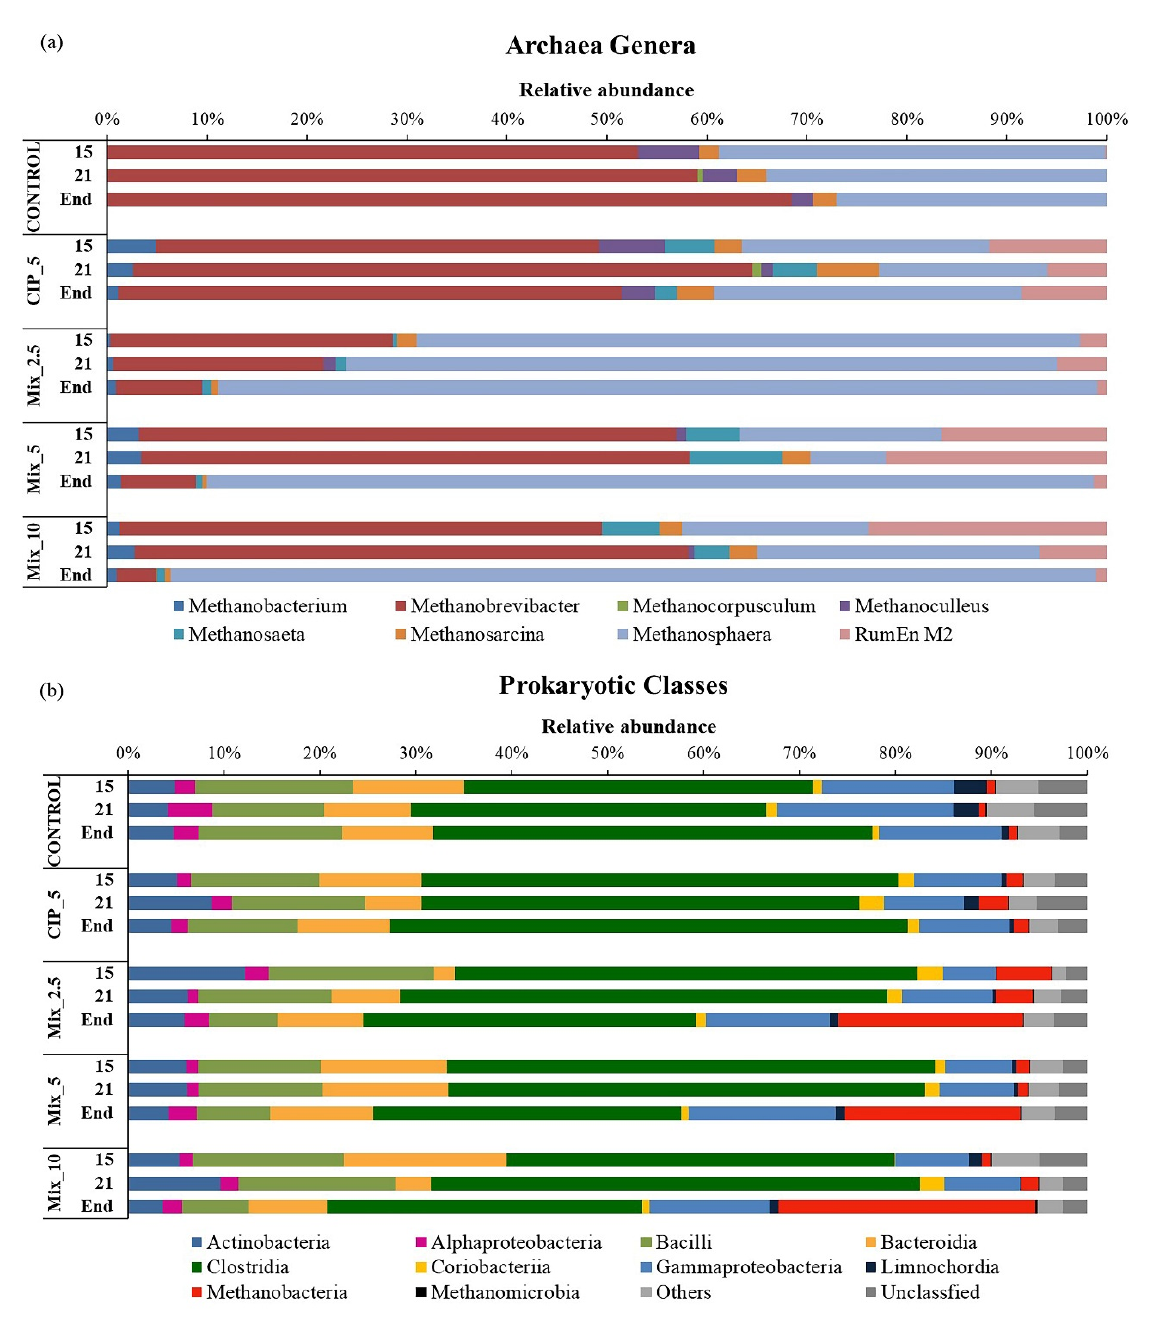
Figure 5. ( a ) Relative abundance of Archaea genera in all experimental conditions evaluated by NGS at genus level and ( b ) relative abundance of prokaryotic cells in all experimental conditions evaluated by NGS at class level.